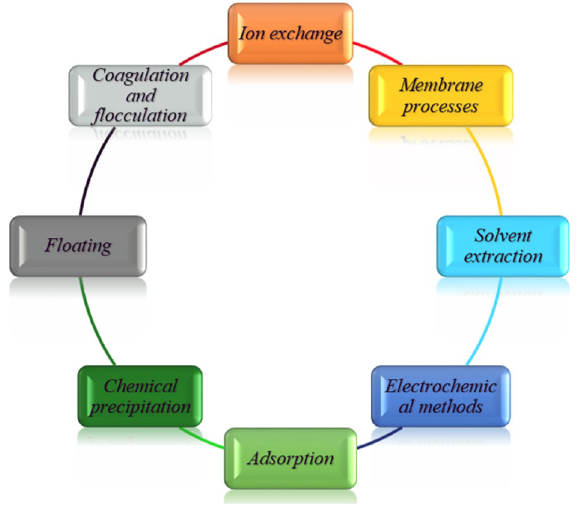
Figure 1. Various physical, chemical, and biological mechanisms for removal heavy metal